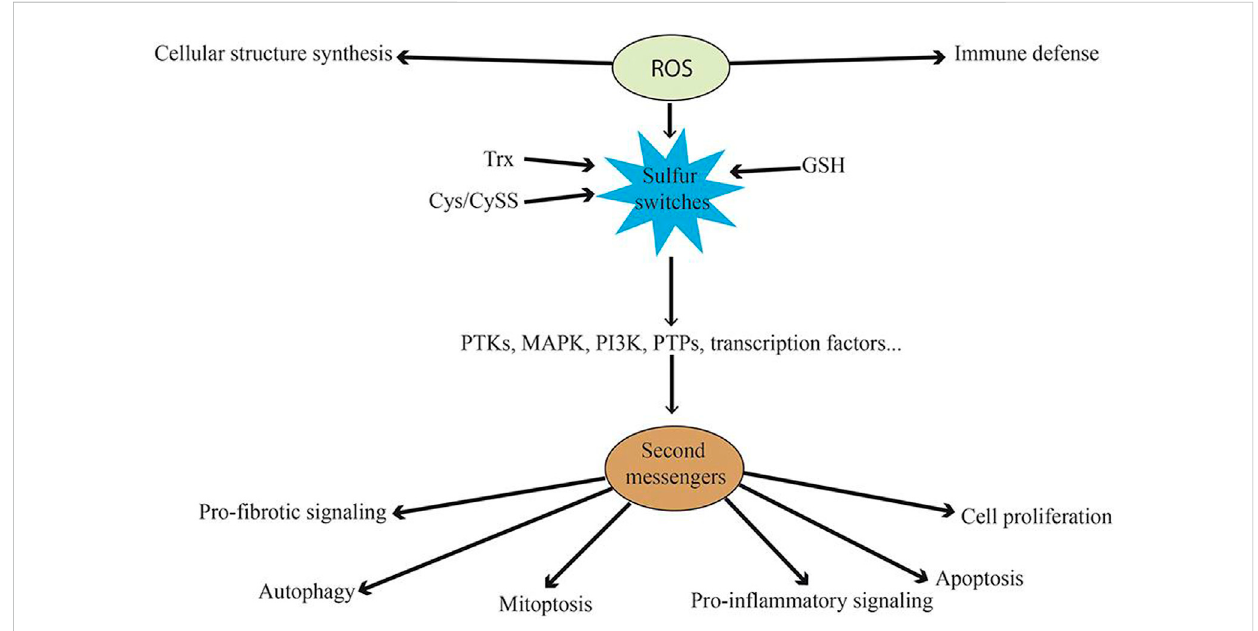
FIGURE 6 Aschematicillustrationofthemechanismthroughwhichtheoxidativeprocessfacilitatesdiseaseprogression.Thereactiveoxygenspeciesinteracts with immune cells and in fl uences cellular structure synthesis, informing the basis of the disease progression pathway.